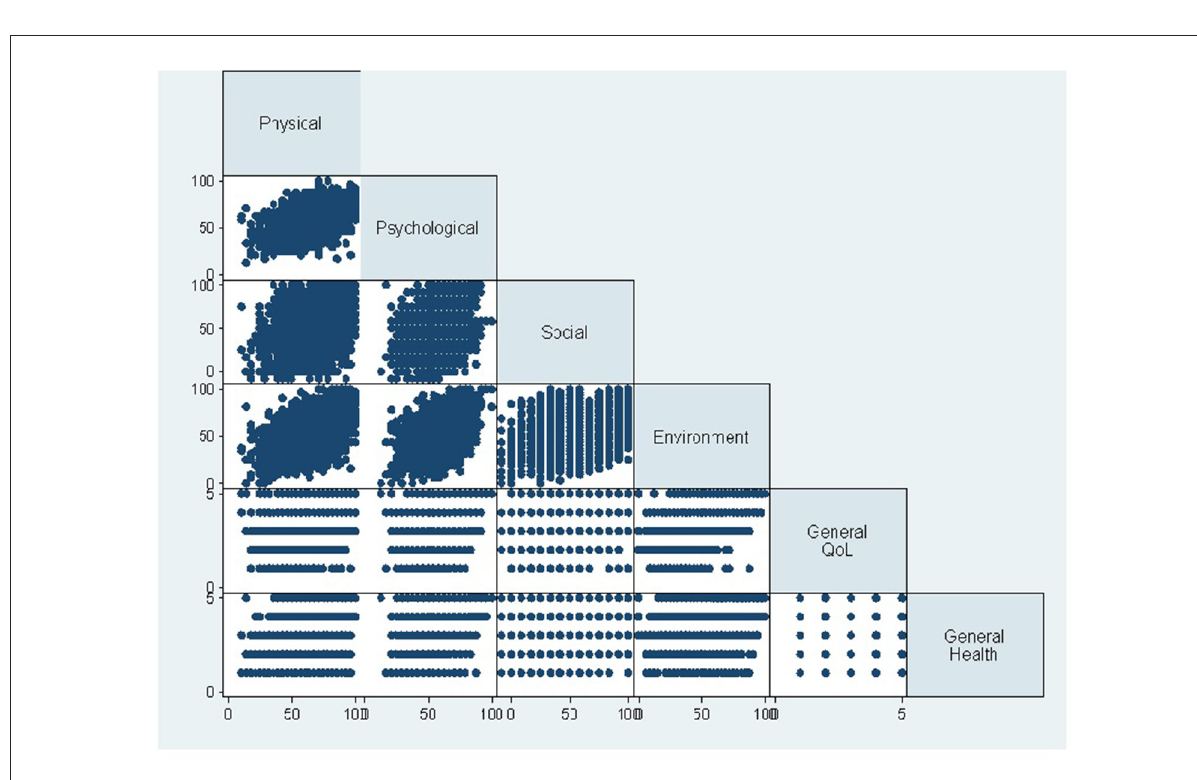
FIGURE2 The correlation between different domains of quality of life (QoL), general health, and general